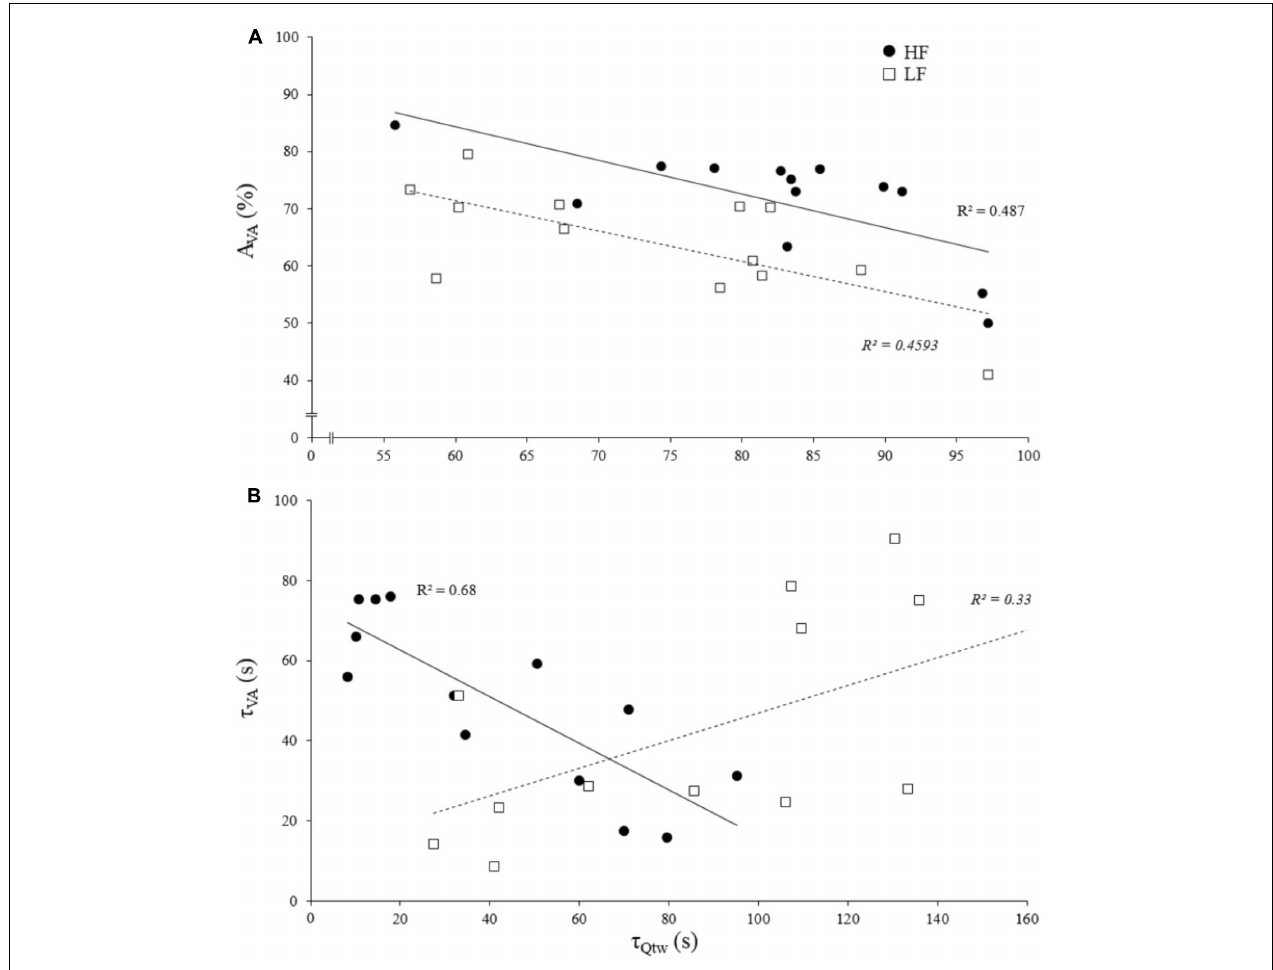
FIGURE 5 | Correlation of evoked torque and voluntary activation for asymptotes and curvature constant of the exponential fatigue kinetics model. Each dot represent an individual. (A) Evoked torque (Q tw ) and voluntary activation (VA) asymptote correlations for knee extensions performed with high force (HF) and low force (LF). (B) Evoked torque (Q tw ) and voluntary activation (VA) curvature constant ( τ ) correlations for knee extensions performed with high force (HF) and low force (LF). All correlations are statistically significant, p <